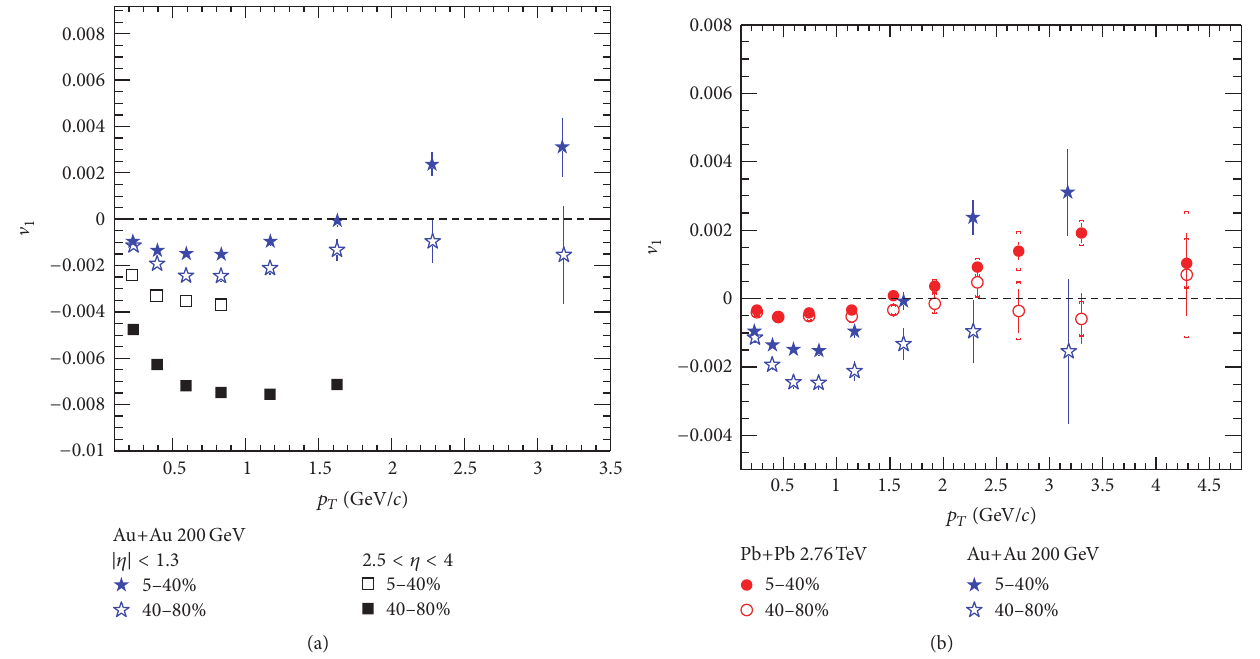
Figure 1: (a) Charged particle V 1 as a function of transverse momentum in 200GeV Au+Au collisions at RHIC, for two centralities and two pseudorapidity windows ( |𝜂| < 1.3 and 2.5 < 𝜂 < 1.3 ) [44]. (b) Comparison of RHIC results with midrapidity measurements in 2.76 TeV Pb+Pb collisions at the LHC